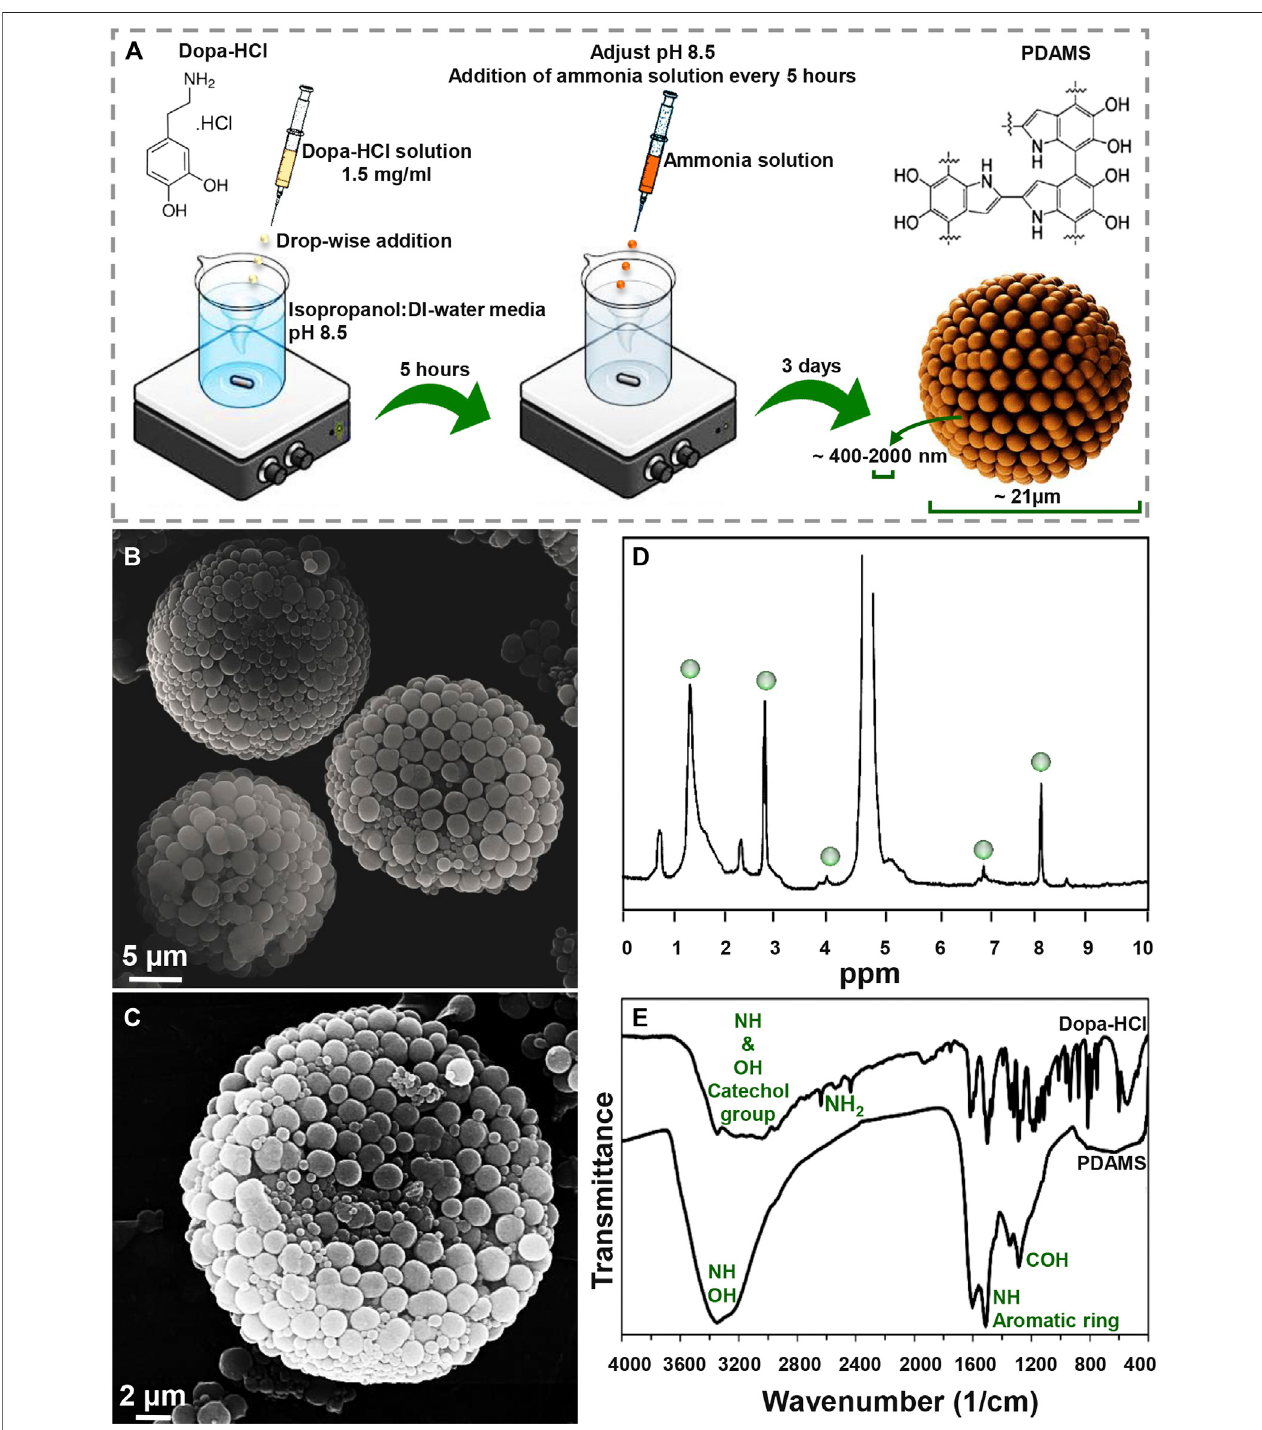
FIGURE 1 | Morphological and chemical observation of pomegranate-like PDAMS (A) A schematic of the synthesis process (B) FE-SEM micrographs of homogeneous nanostructured PDAMS, which were synthesized by spontaneous oxidation under controlled pH (C) FE-SEM micrographs of the inner structure of PDAMS (D) H-NMR and (E) FTIR of polymerized microspheres.